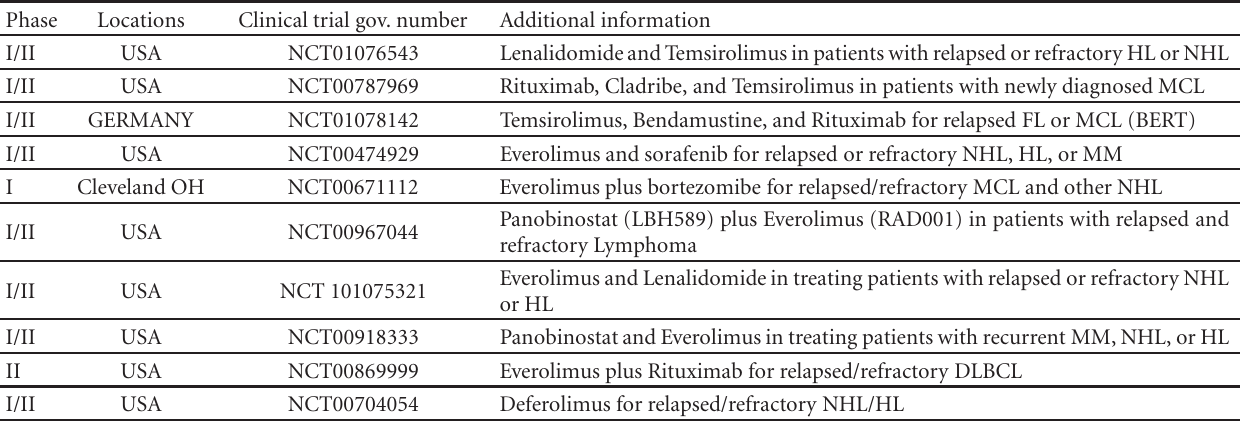
Table 2: Ongoing clinical trials with rapalogs in patients with